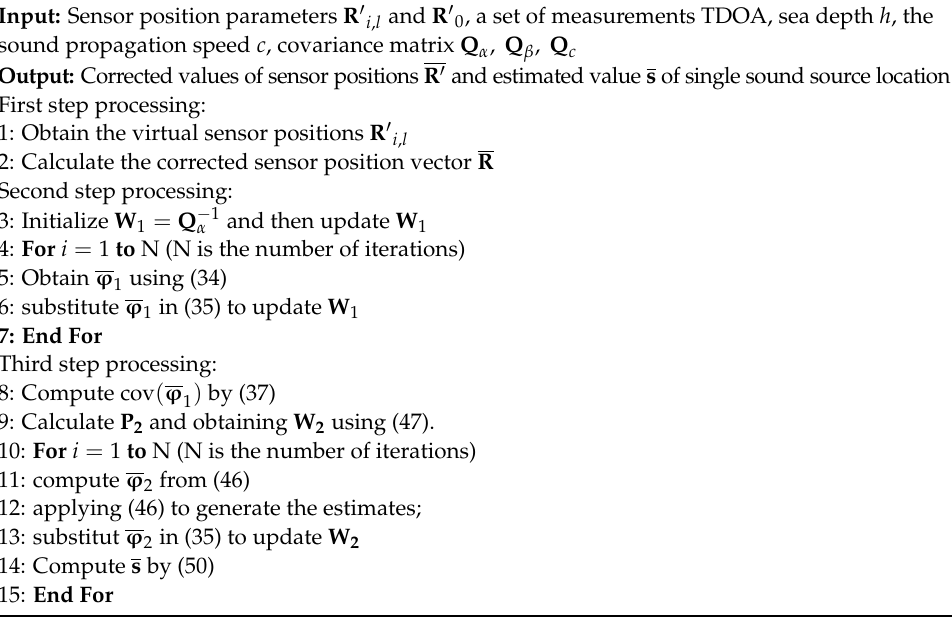
Algorithm 1: The proposed closed-form